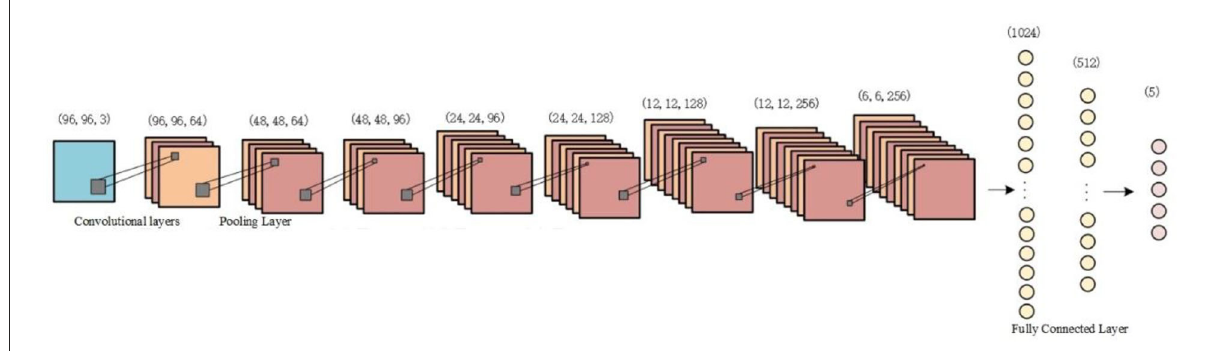
FIGURE6 Convolutional neural network (CNN) model structure diagram.